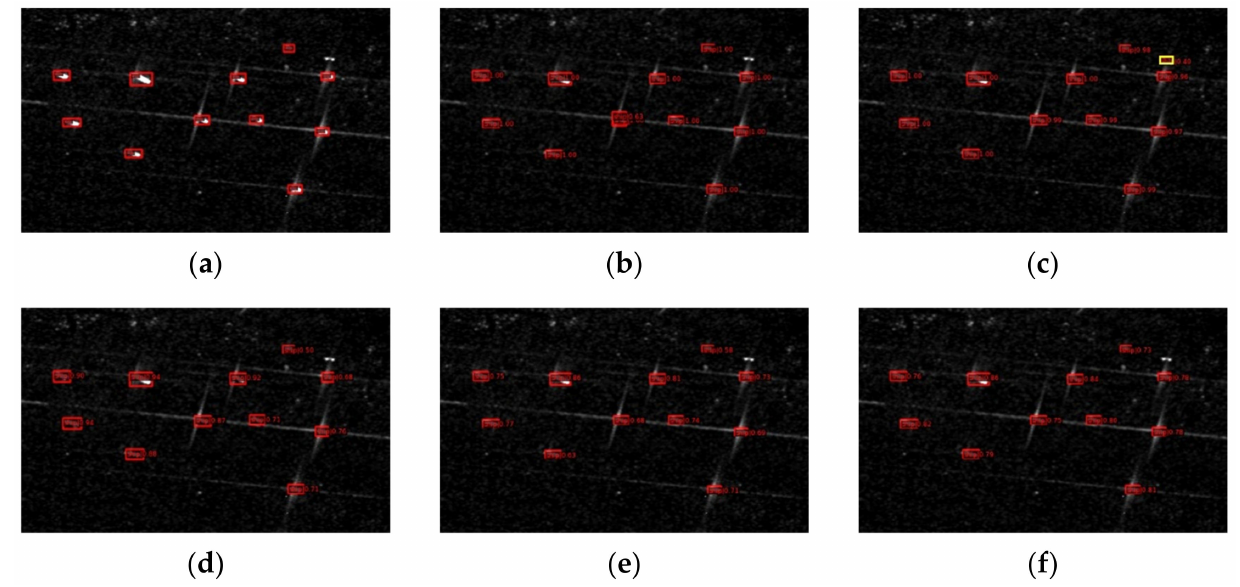
Figure 12. Visualization detection results of off-shore scenes in the SSDD dataset: ( a ) ground truth; ( b ) Faster RCNN; ( c ) Cascade RCNN; ( d ) Retinanet; ( e ) FCOS; and ( f ) proposed method. (The red boxes represent ground truths and true positives; the yellow boxes represent false alarms).